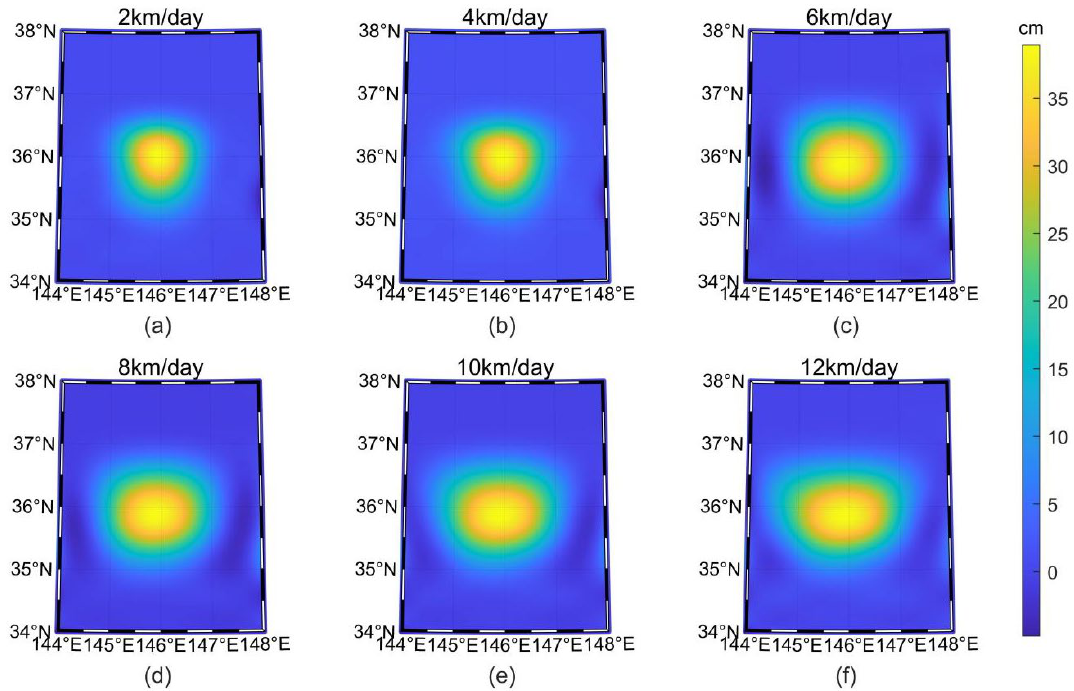
Figure 10. The fitting results of the B-spline surface under the optimal frequency combination corresponding to different westerly moving velocities. ( a – f ) Westerly moving velocities stepped from 0 to 12 km/day in 2 km/day steps, respectively.